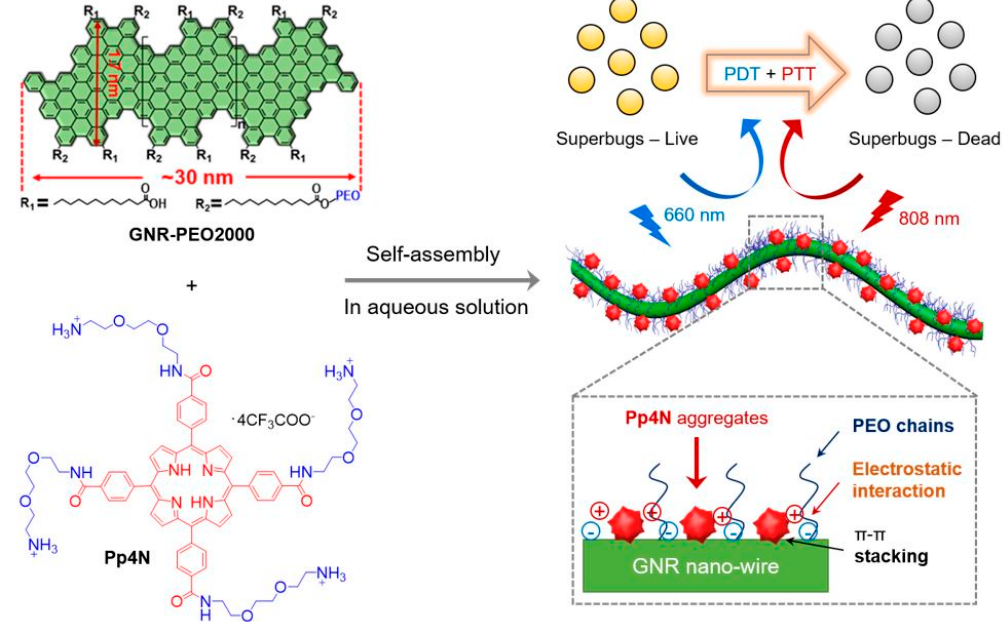
Figure 10. Structures of cationic porphyrin (Pp4N) and water-dispersible graphene nanoribbons (GNRs) with a poly(ethylene oxide) (PEO) grafting percentage of 42% (GNR-PEO2000) used for self-assembly and double-light activated photodynamic and photothermal therapy of drug-resistant bacteria (superbugs). Reproduced from [78], with permission from John Wiley and Sons, 2020.